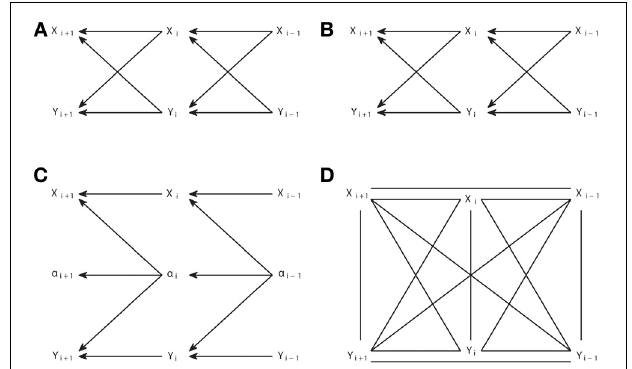
FIGURE 5 | Causal structures corresponding to interacting dynamic processes (A,C) and their corresponding embedded patterns retrieved from the IC ∗ algorithm